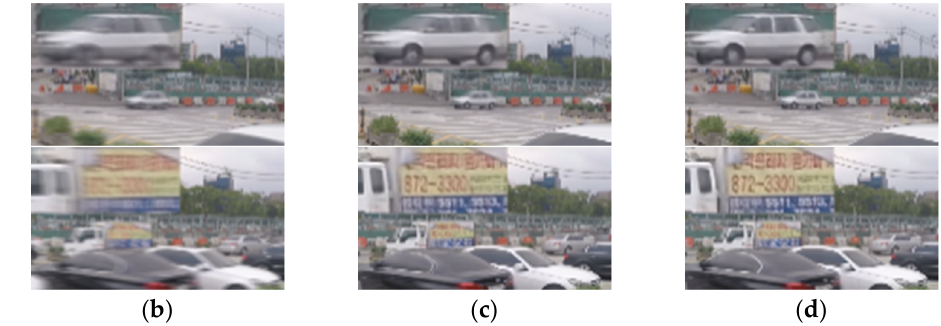
Figure 7. Ablation Experiment of Texture Sub-Network. ( a ) ground truths; ( b ) blurred images; ( c ) deblurring results of IDC without Sub-Texture; ( d ) deblurring results of IDC (proposed).